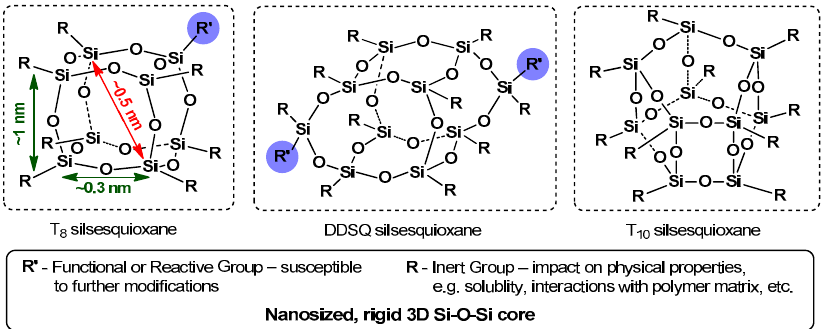
Figure 1. The hybrid (i.e., organic–inorganic) nanostructures of respective cubic T 8 , DDSQ and T 10 silsesquioxanes.